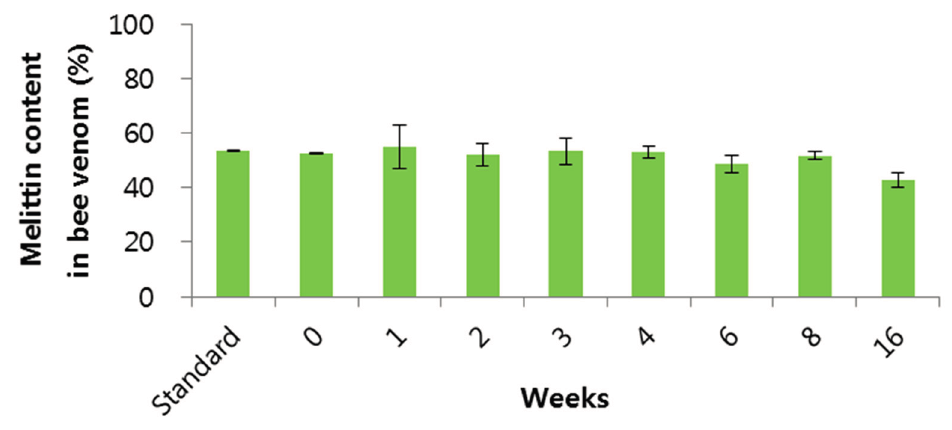
Figure 3. The melittin content in bee venom according to storage period. Data are expressed as the mean ± SD ( n = 3).